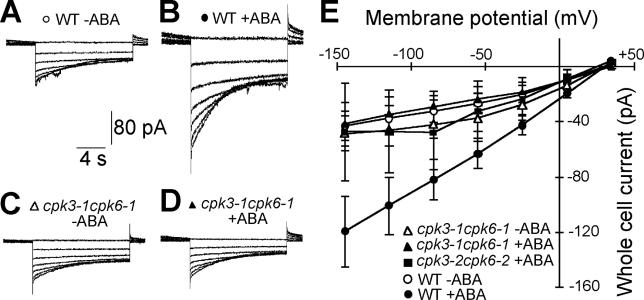
Impairment in ABA Activation of S-Type Anion Channel Currents in cpk3cpk6 Mutant Guard Cells(A and B) Whole-cell S-type anion channel current traces in wild-type (WT) guard cells in the absence of ABA (A) and in the presence of 50 μM ABA (B).(C and D) Whole-cell S-type anion channel current traces in cpk3-1cpk6–1 double mutant guard cells in the absence of ABA (C) and in the presence of ABA (D).(E) Average current-voltage curves of wild-type and cpk3-1cpk6–1 and cpk3-2cpk6–2 double mutant guard cells in the absence and presence of ABA (n = 8 WT; n = 7 cpk3-1cpk6–1; n = 3 cpk3-2cpk6–2 guard cells). GCPs were treated with 50 μM ABA or solvent control (0.1% ethanol) for 2 h prior to establishing gΩ seals. Open and closed symbols indicate −ABA and +ABA, respectively.